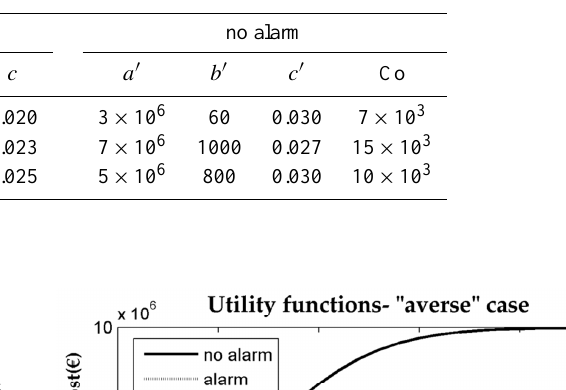
Table 1. Utility function parameters (FLOODsite, 2008).